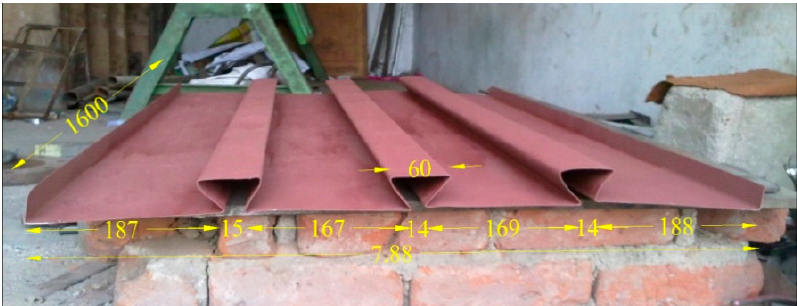
Figure 3. Dovetailed or re-entrant profiled sheet (All dimensions are in mm).